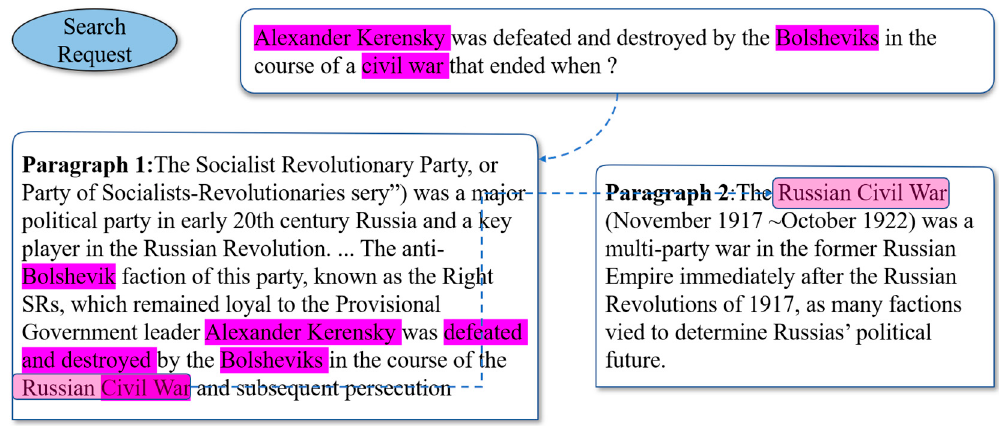
Figure 2. A complex example of an open-domain retrieval task from HotpotQA. Paragraph 2 is di ffi cult to be retrieved using traditional retrievers due to little lexical overlap with the given query.